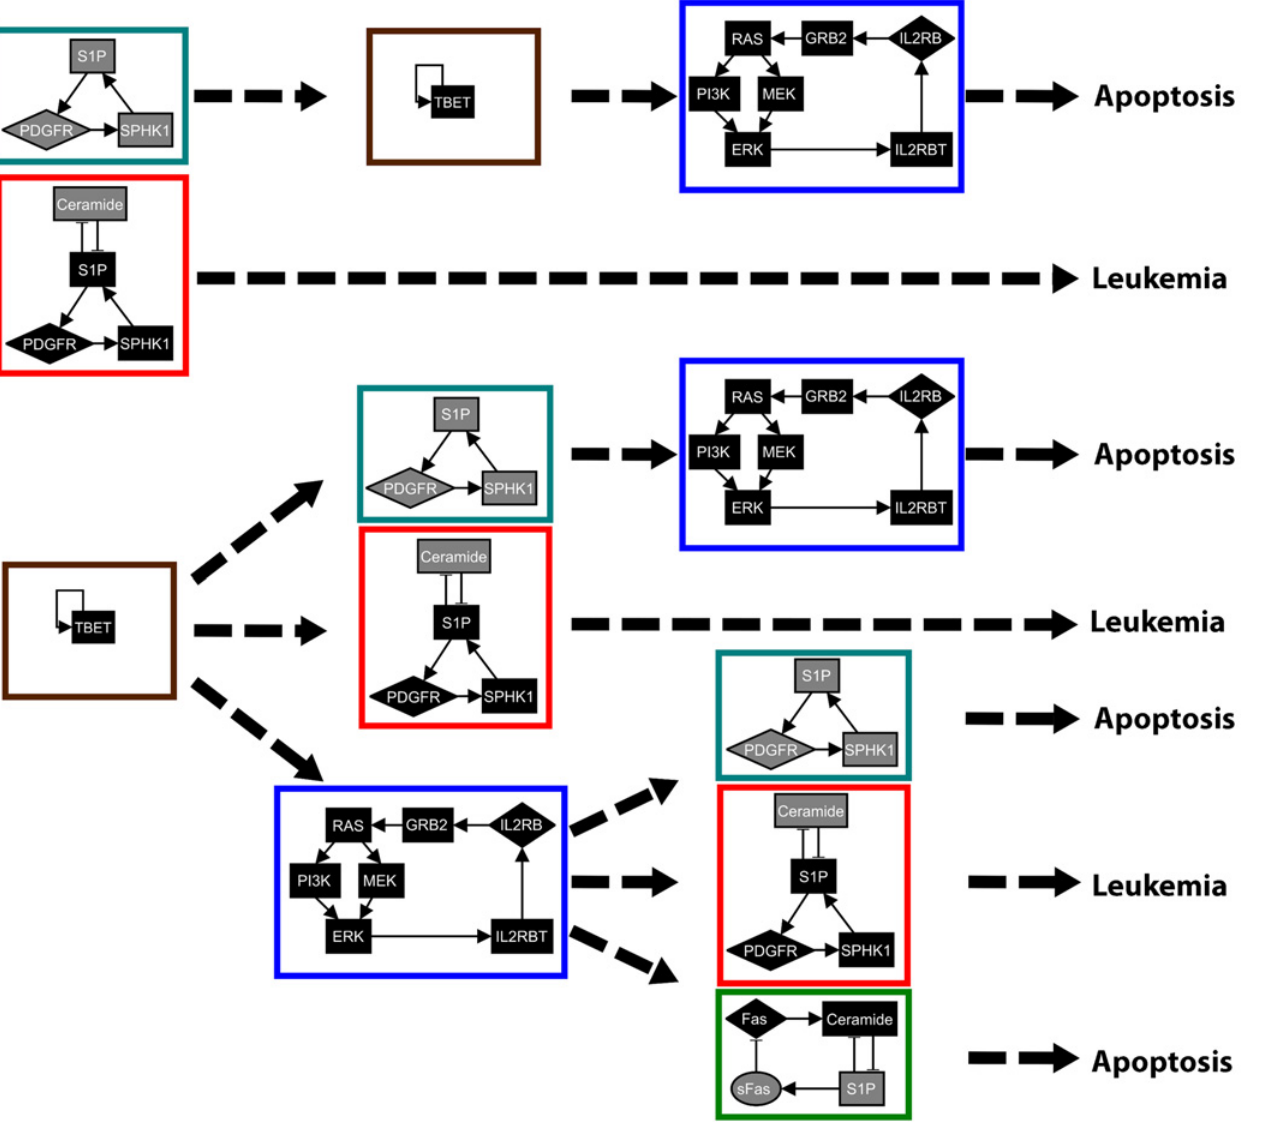
Fig 4. Stable motif succession diagram for the T-LGL leukemia network. The color of the nodes denotes their respective node states in the stable motifs: gray for 0 and black for 1. The colored rectangle surrounding each stable motif corresponds to the respective color of the motif in Fig 3. There are two possible attractors for the system: the normal state of self-programmed cell death (apotosis) and the diseased state (T-LGL leukemia). The attractors obtained for each possible sequence of stable motifs are shown in the rightmost part of the figure.